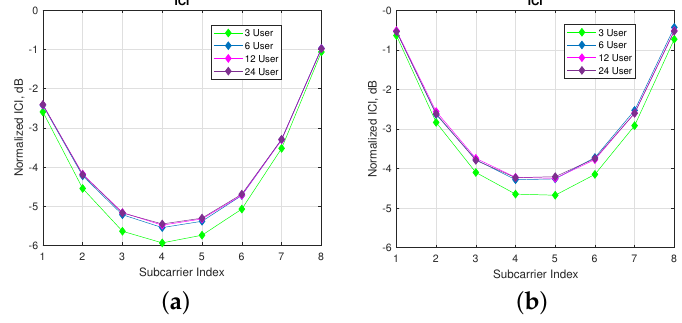
Figure 9. ICI analysis for ISA SMS regarding to various number of machine users. ( a ) ISA SMS with s = 8 and v = 3. ( b ) ISA SMS with s = 8 and v =